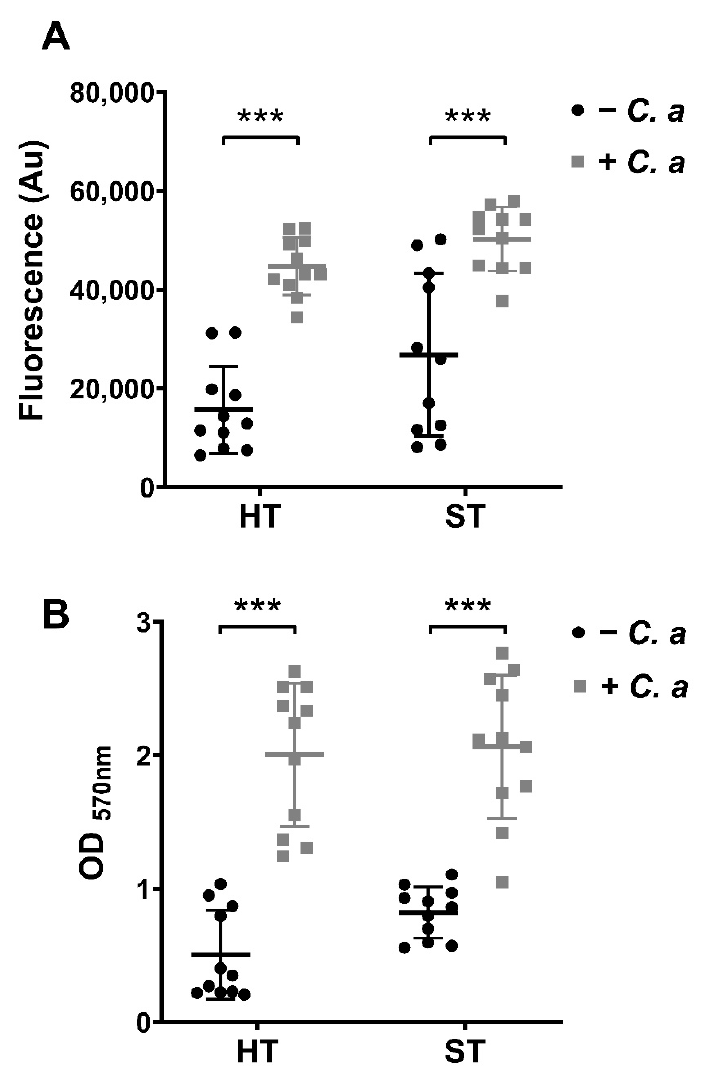
Figure 1. Metabolic and biomass profiles of hard tissue (HT) and soft tissue (ST) biofilms plus or minus Candida albicans . Biofilms were grown in 96 well microtiter plates. Metabolic activity ( A ) was assessed using Alamar blue™ rezasurin dye to determine respiration rates, and biomass ( B ) was assessed using crystal violet as a disclosing stain to interpret differences in biofilm formation. Biofilms were grown and assayed in triplicate or quadruplicate on three separate occasions (a total of n = 11 biofilms from three separate experiments). Data represented as mean ± SD. Statistical analysis performed using an unpaired Mann–Whitney t-test to compare differences in mean (*** p < 0.001).